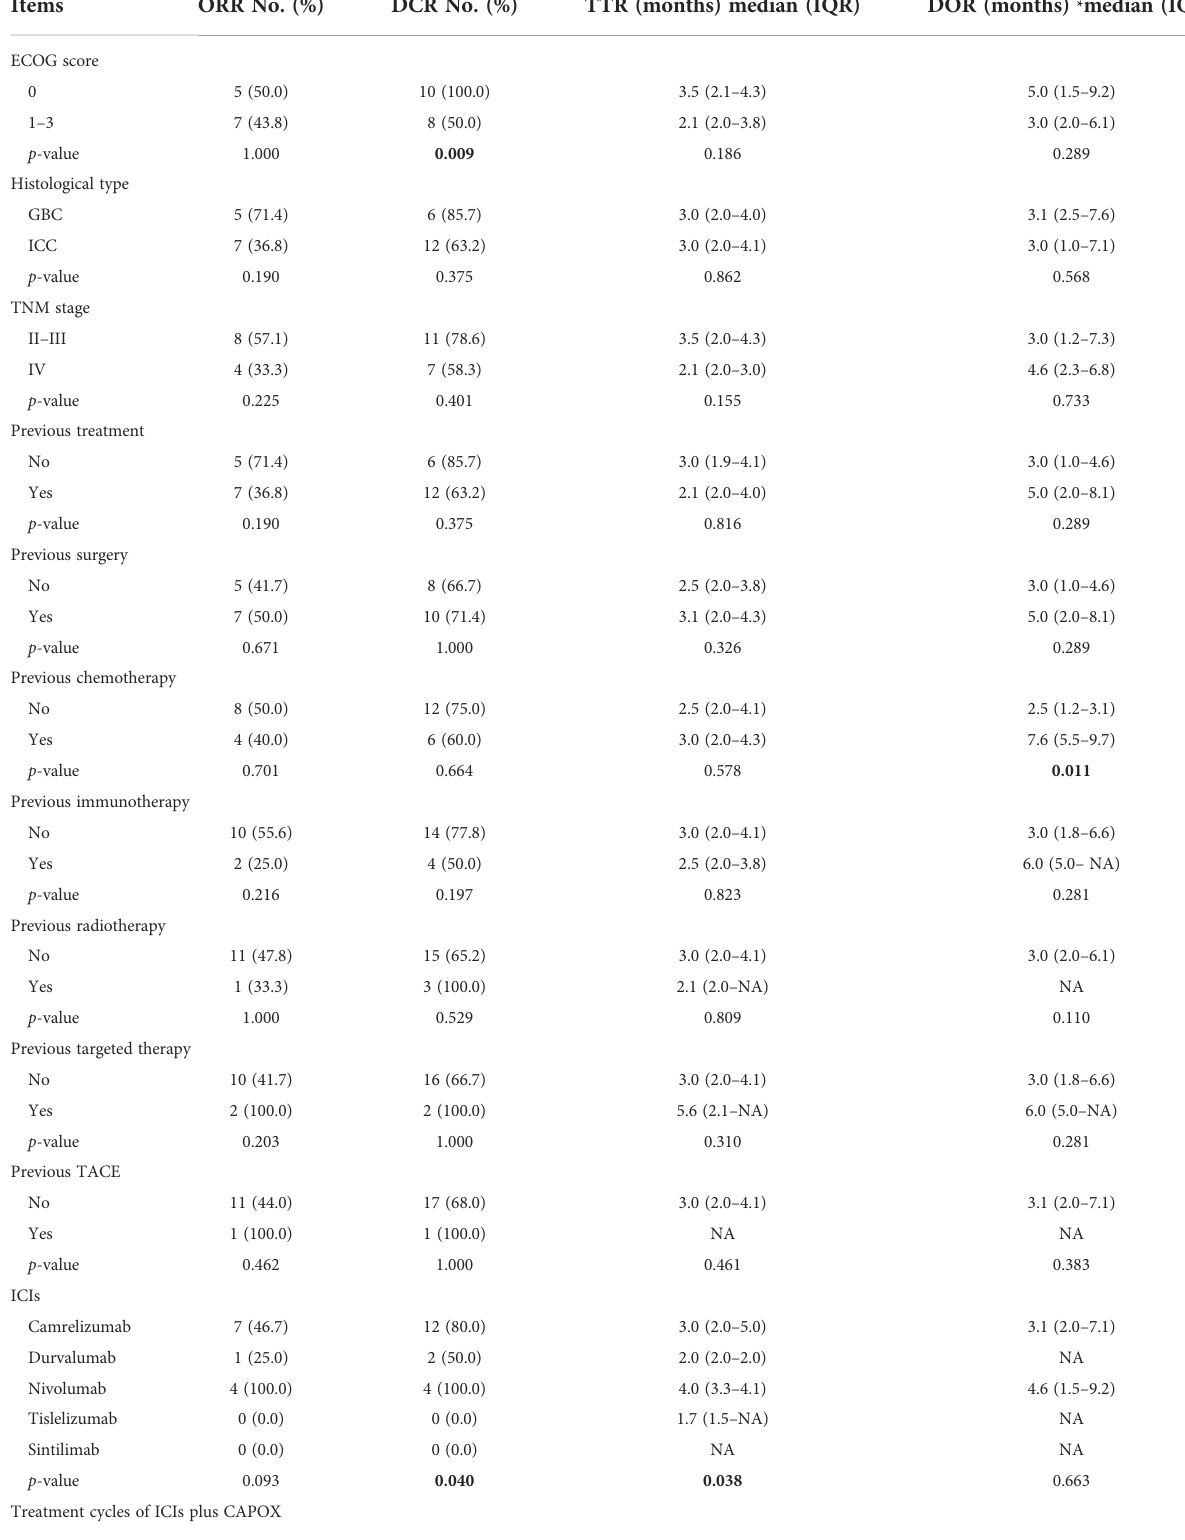
TABLE 3 Best treatment response for patients with different